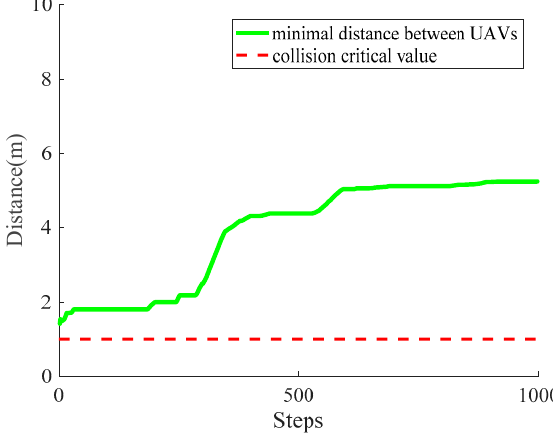
Figure 15. The variation of the minimum distance between UAVs.